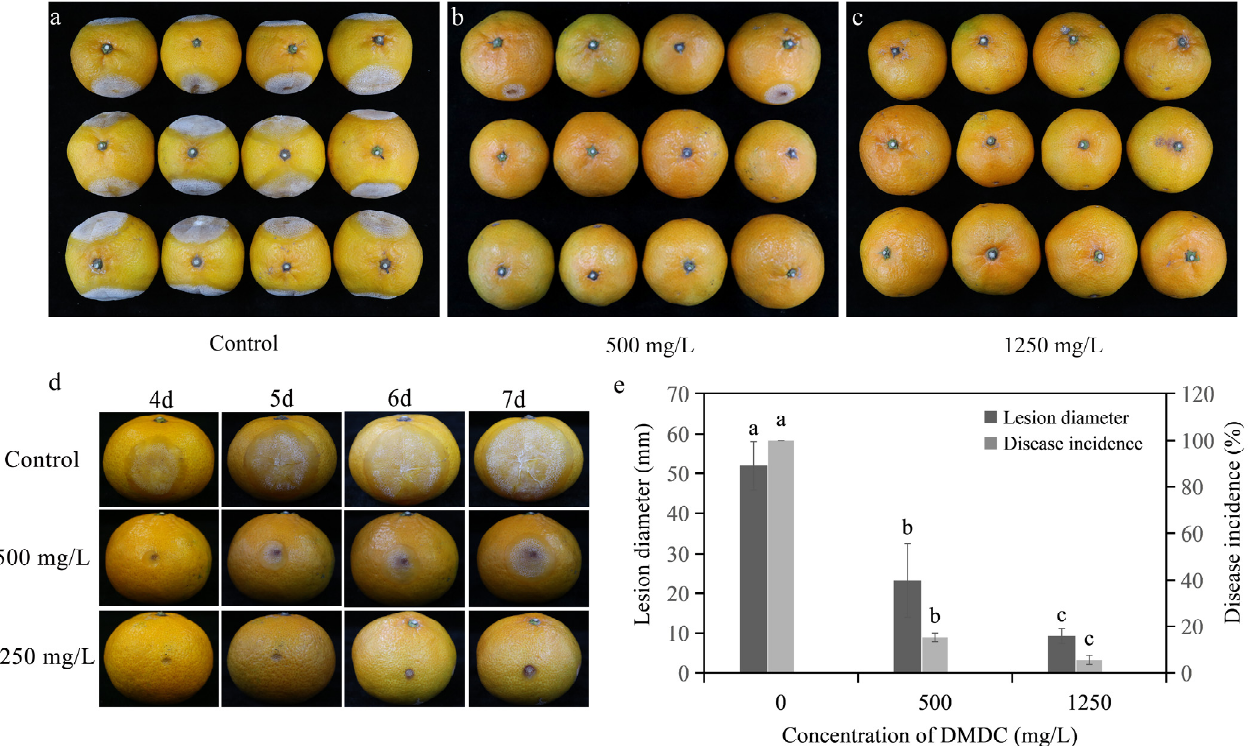
Figure 8. Inhibitory effect of DMDC against G. citri-aurantii on citrus fruits. ( a – c ) The incidence of all fruits with different treatments at 7 days after inoculation; ( d ) the fruits of different treatments after 4–7 days of inoculation; ( e ) the effects of DMDC treatment on fruit disease incidence and disease diameter. The data represent the mean ± standard deviation (SD). Different letters on each column represent significant differences ( p < 0.05 ) according to Duncan’s test. Table 1. Results of fruit quality determination after DMDC treatment .